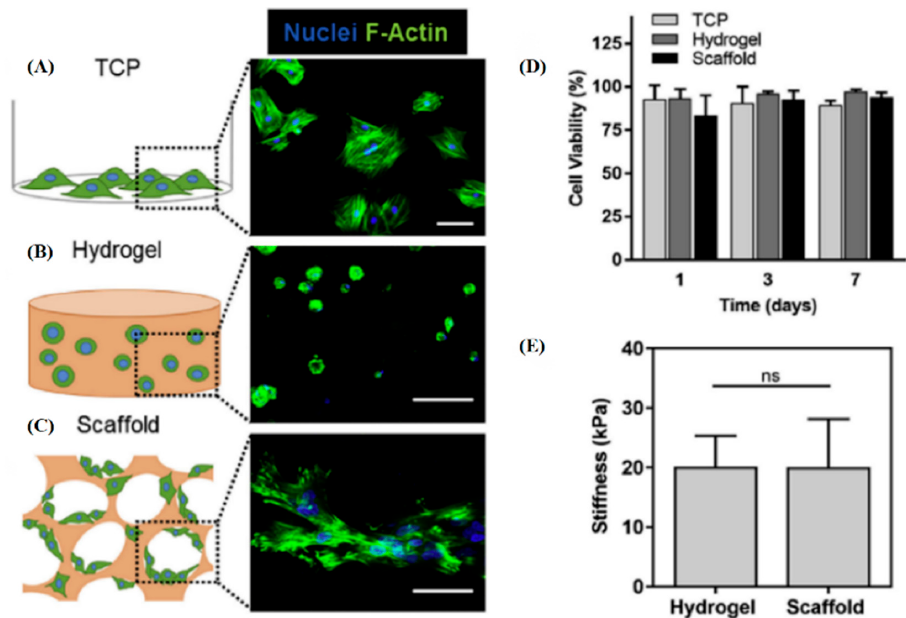
Figure 3. The schematic depiction and corresponding morphological evaluation of MSCs cultured in different substrate microenvironments: ( A ) TCP well plate, ( B ) encapsulated in an alginate hydrogel, and ( C ) seeded on a macroporous alginate scaffold. MSCs were stained with DAPI (nuclei = blue) and Phalloidin (F-Actin = green). Scales ( A ) and ( B ) = 100 μ m, and ( C ) = 50 μ m. ( D ) MSCs maintained long-term viability on the three substrates after 1, 3, and 7 days. ( E ) Alginate hydrogels and scaffolds showed similar mechanical properties. Reprinted with permission from [179], Copyright 2017, Elsevier.